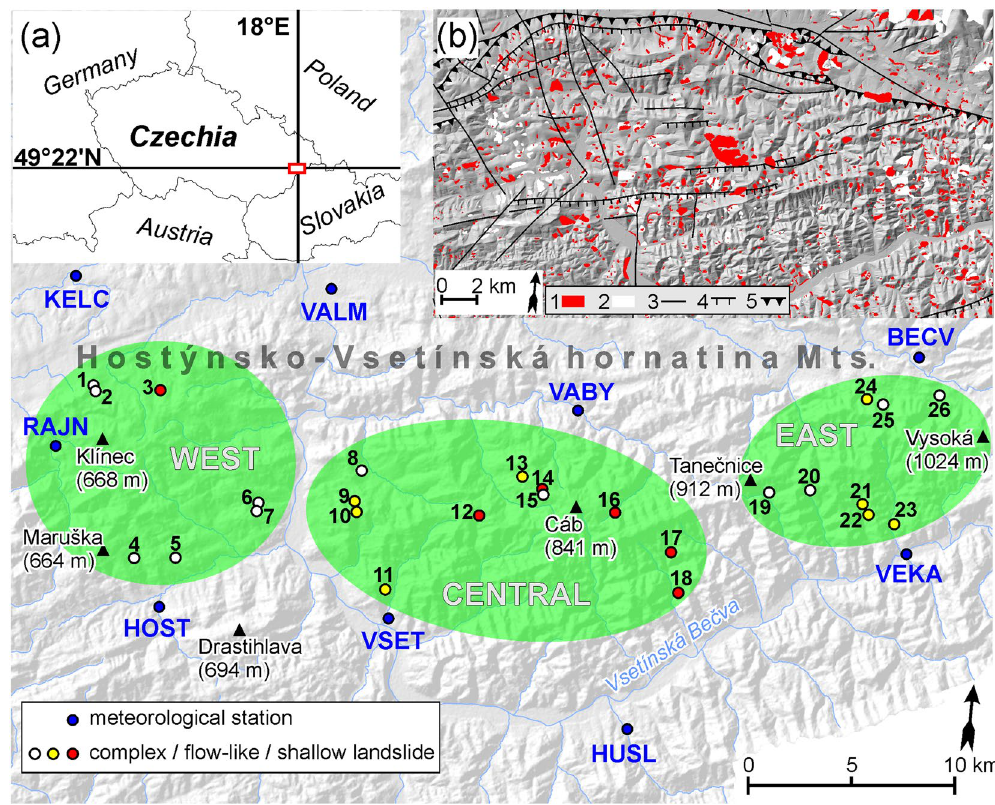
Figure 1. Location of landslide sites and meteorological stations. Map ( a ) shows the location of the study region within Central Europe. Map ( b ) shows the distribution of known landslides and tectonic features 75,76 : 1 – active landslides; 2 – non-active landslides; 3 – normal fault; 4 – thrust fault; 5 – fold nappe. Maps were created and modified in the ArcMap 10.1 software (ESRI; https://www.esri.com/en-us/home). Source of base maps: images of SRTM 1 Arc-Second Global 77 available from USGS Earth Explorer